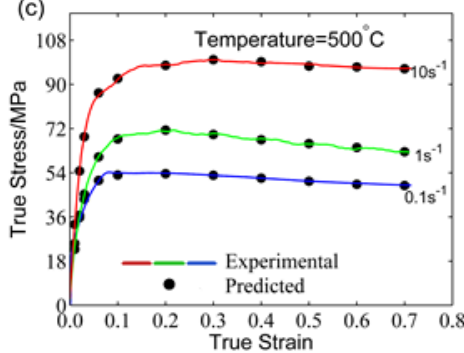
Figure 8. Comparisons of the predicted and experimental flow stress by the non-optimized ANN model at: ( a ) 300 °C, ( b ) 400 °C, and ( c ) 500 °C.